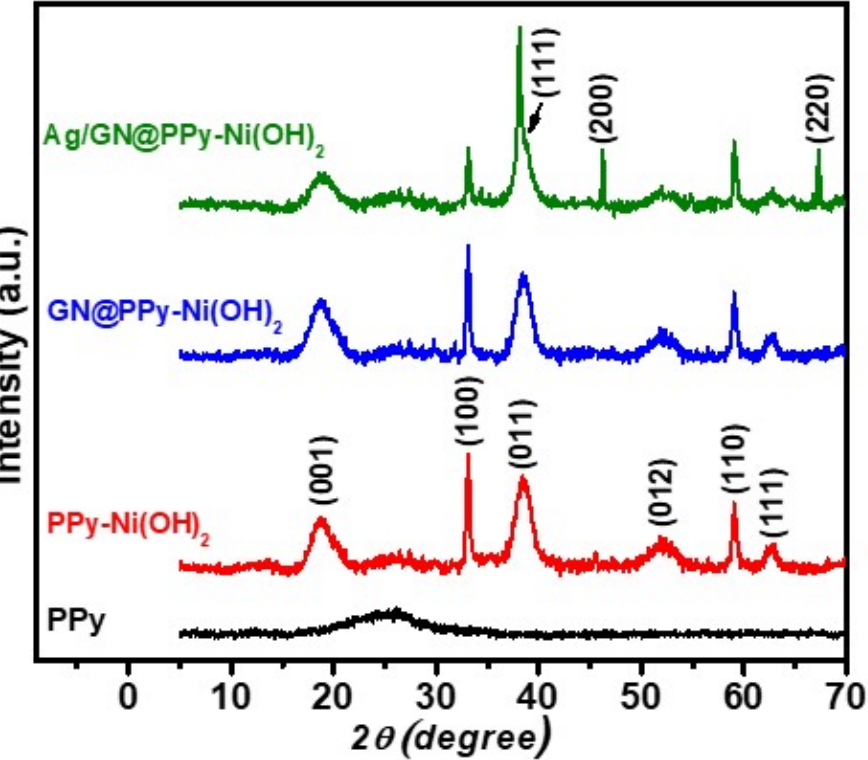
Figure 3. X-ray diffraction spectra of PPy, PPy − (Ni(OH) 2 , GN@PPy–Ni(OH) 2 , and Ag/GN@PPy– Figure 3. X ‐ ray diffraction spectra of PPy, PPy − (Ni(OH) 2 , GN@PPy − Ni(OH) 2 , and Ni(OH) 2 Ag/GN@PPy − Ni(OH) 2 .